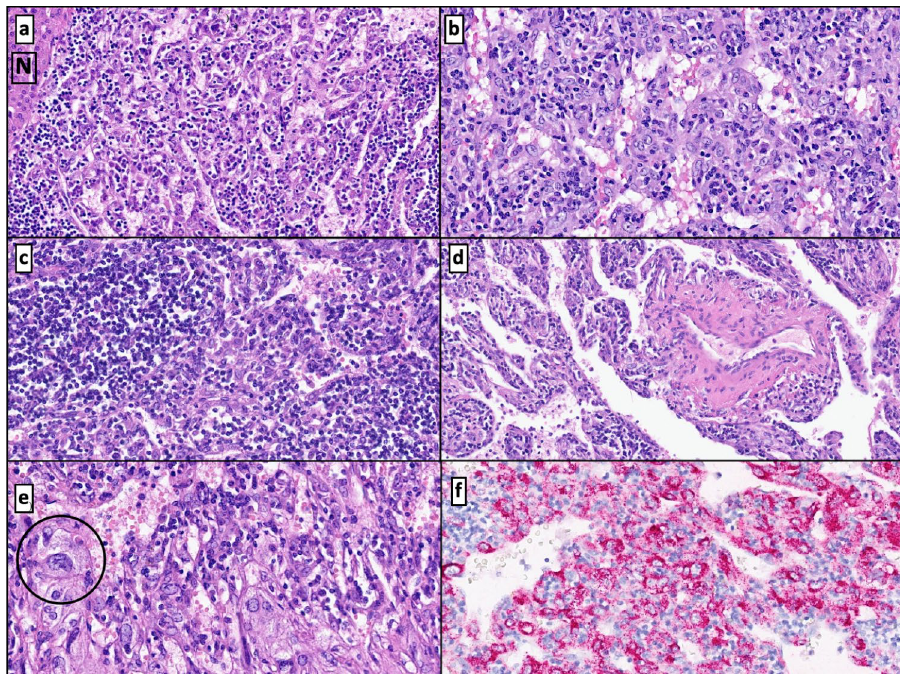
Fig. 4 Solid neoplasm with vascular channels encircled by normal liver parenchyma (N) of well-defined borders (a) . The lesion shows pseudovascular patterns with abundant lymphocytes, perivascular eosinophils, and epithelioid cells (b) . Tumor-associated lymphohistiocytic infiltrate (c) . Thick-wall ves- sels and dilated vascular channels with thin septae hosting tumoral cells (d) . Detail of neoplastic “PEComatous” epithelioid cells of large nuclei neighbor- ing vascular areas (circle) (e) . Positive HMB-45 immunoexpression of tumor cellularity (f)